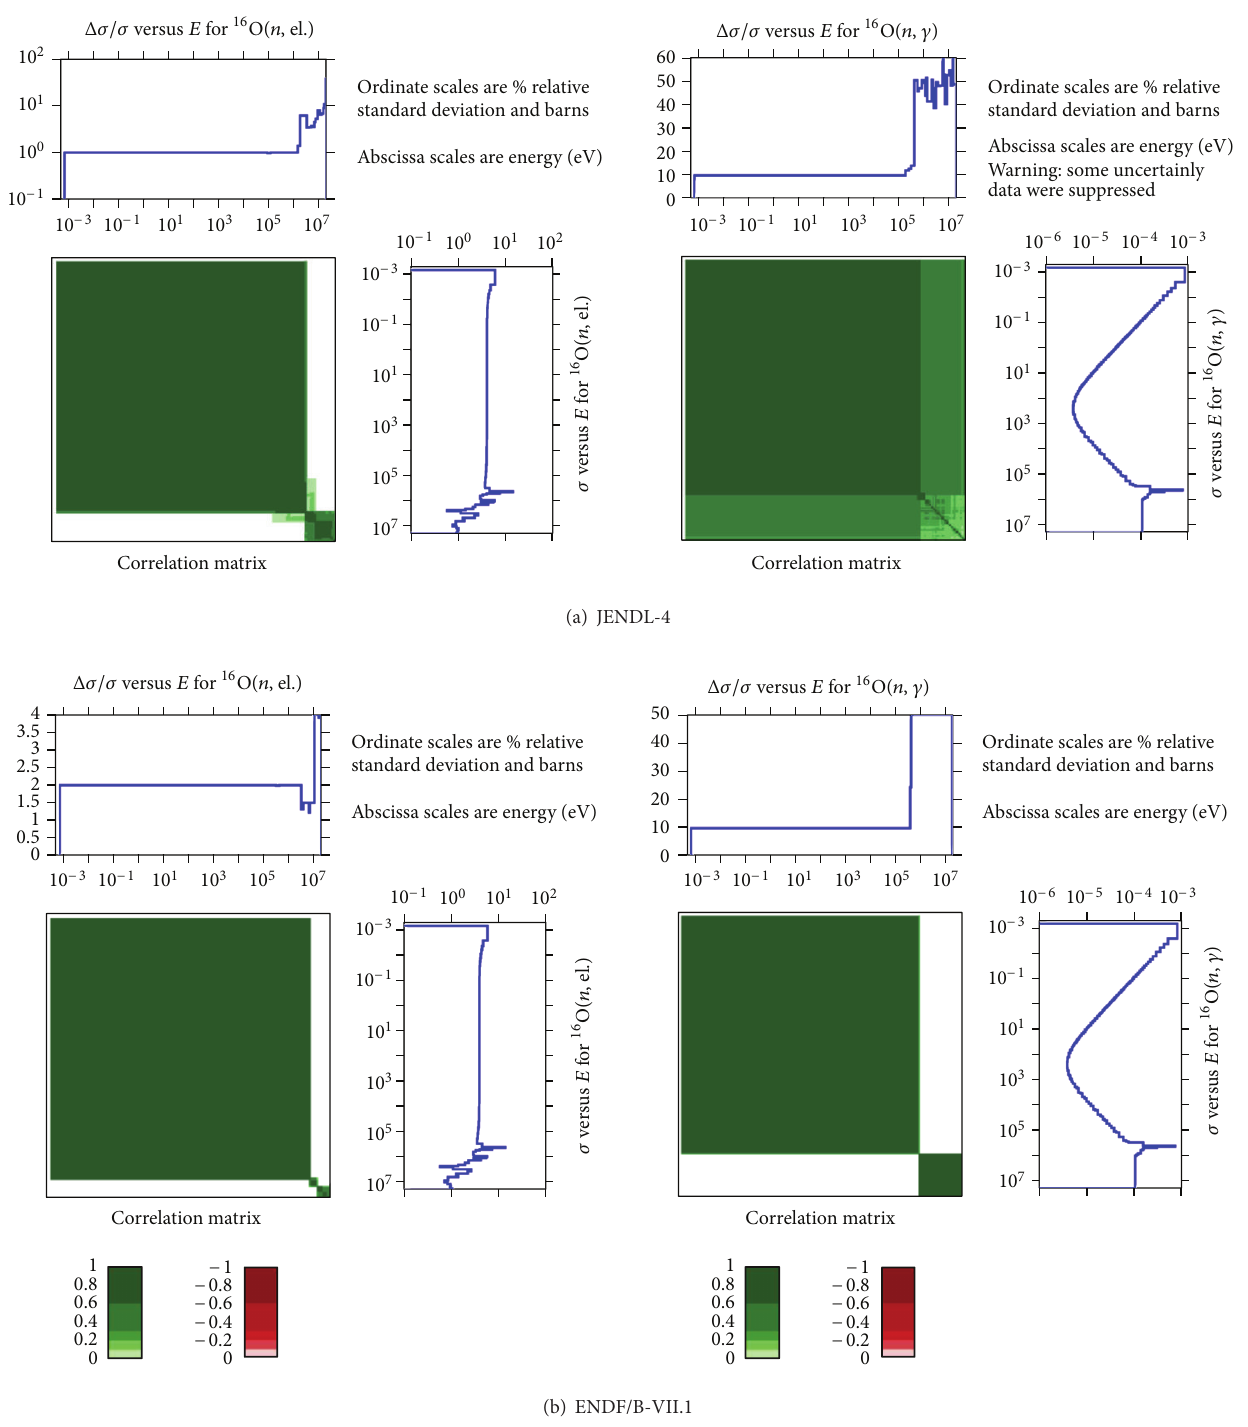
F 2: Covariance plot for